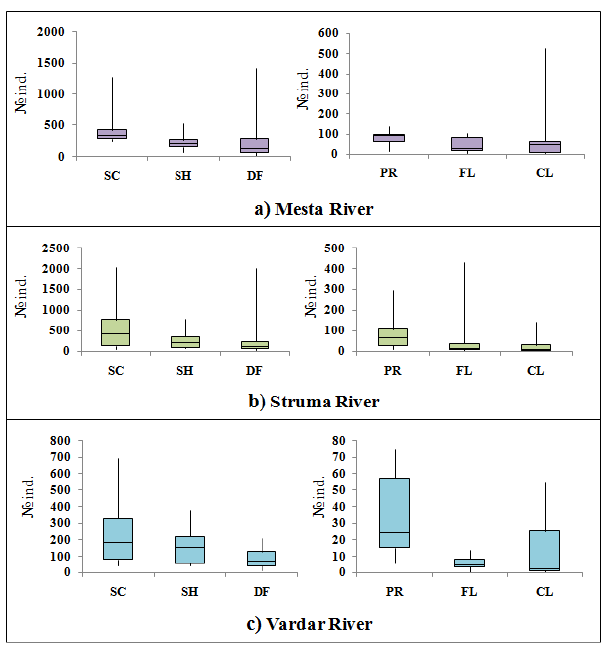
Figure 3. Box plots (median, range and interquartile ranges) of total abundance of the FFGs within the studied watersheds. Legend: x-axis: FFG (for abbreviations, see Materials and Methods); y-axis: total number of individuals.